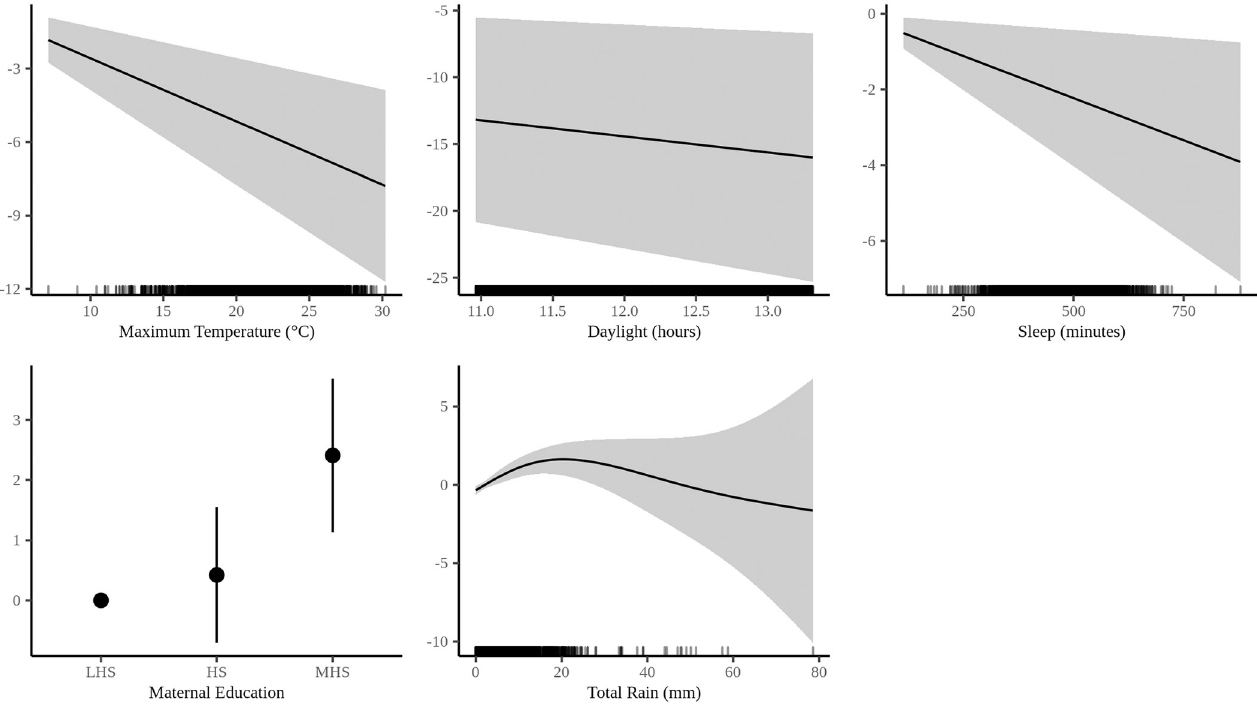
Fig 4. Maximum temperature GAM covariate plots with predicted daily percent sedentary time along y-axis.